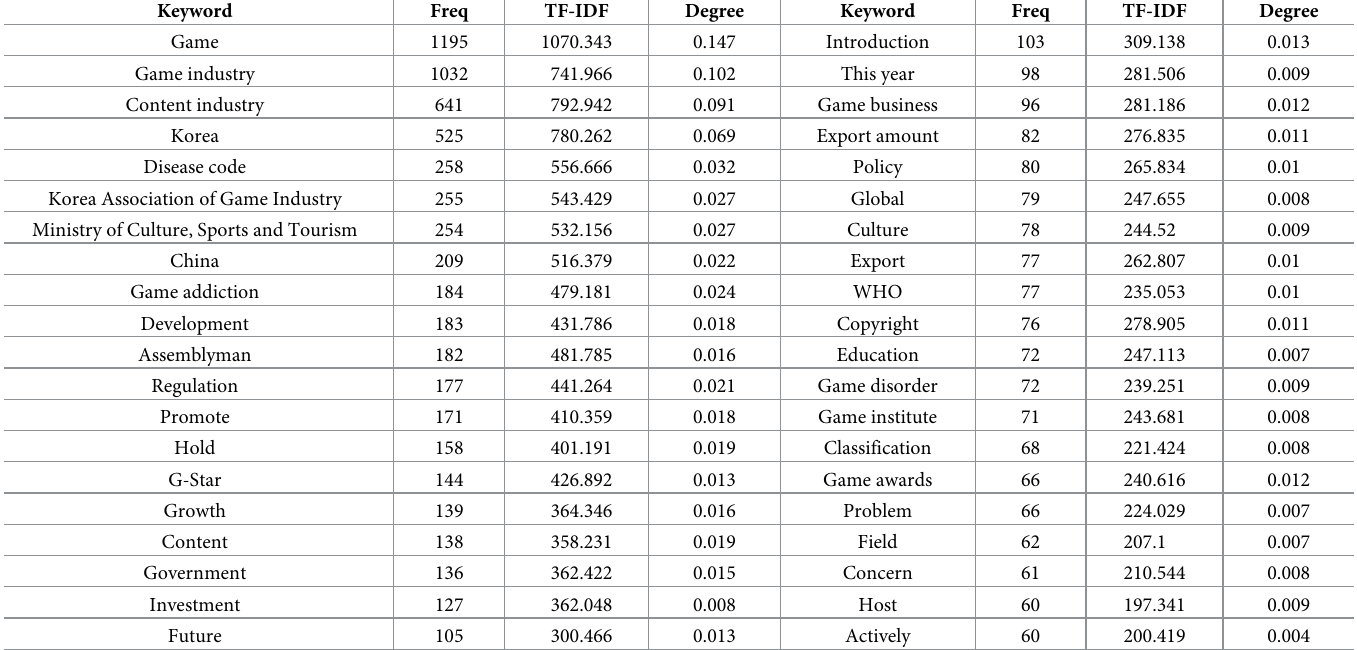
Table 2. The top 40 important keywords of the game industry in